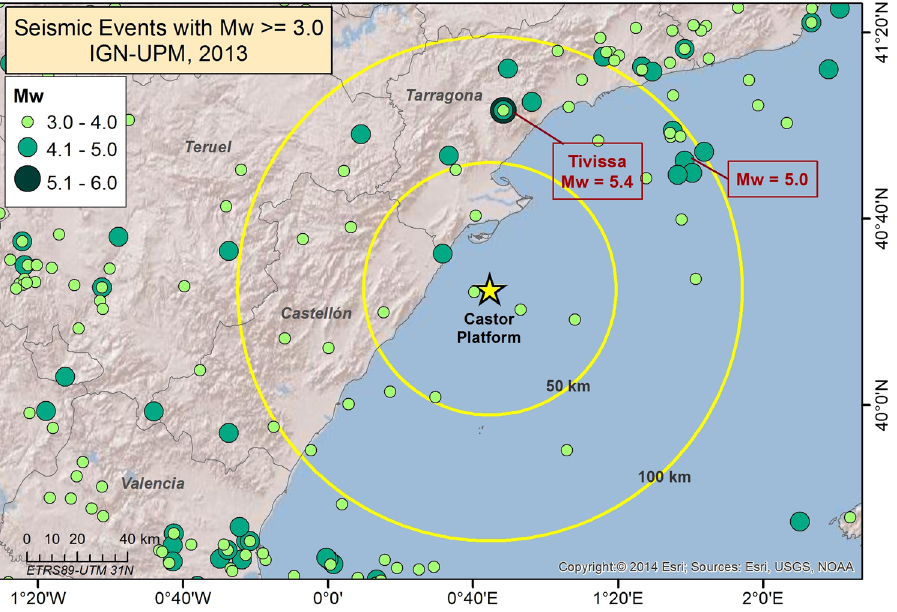
Figure 3. Historical and instrumental seismicity in the area of 100 km around Castor. Time period: 1048-2013 (Data source: IGN 19 ). The figure was generated by using the ESRI software, ArcGIS for desktop, version 10.1.